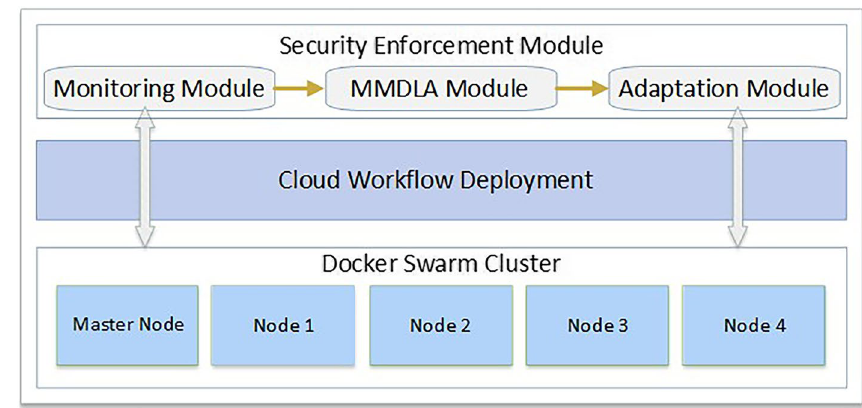
Fig. 4 Experimentation